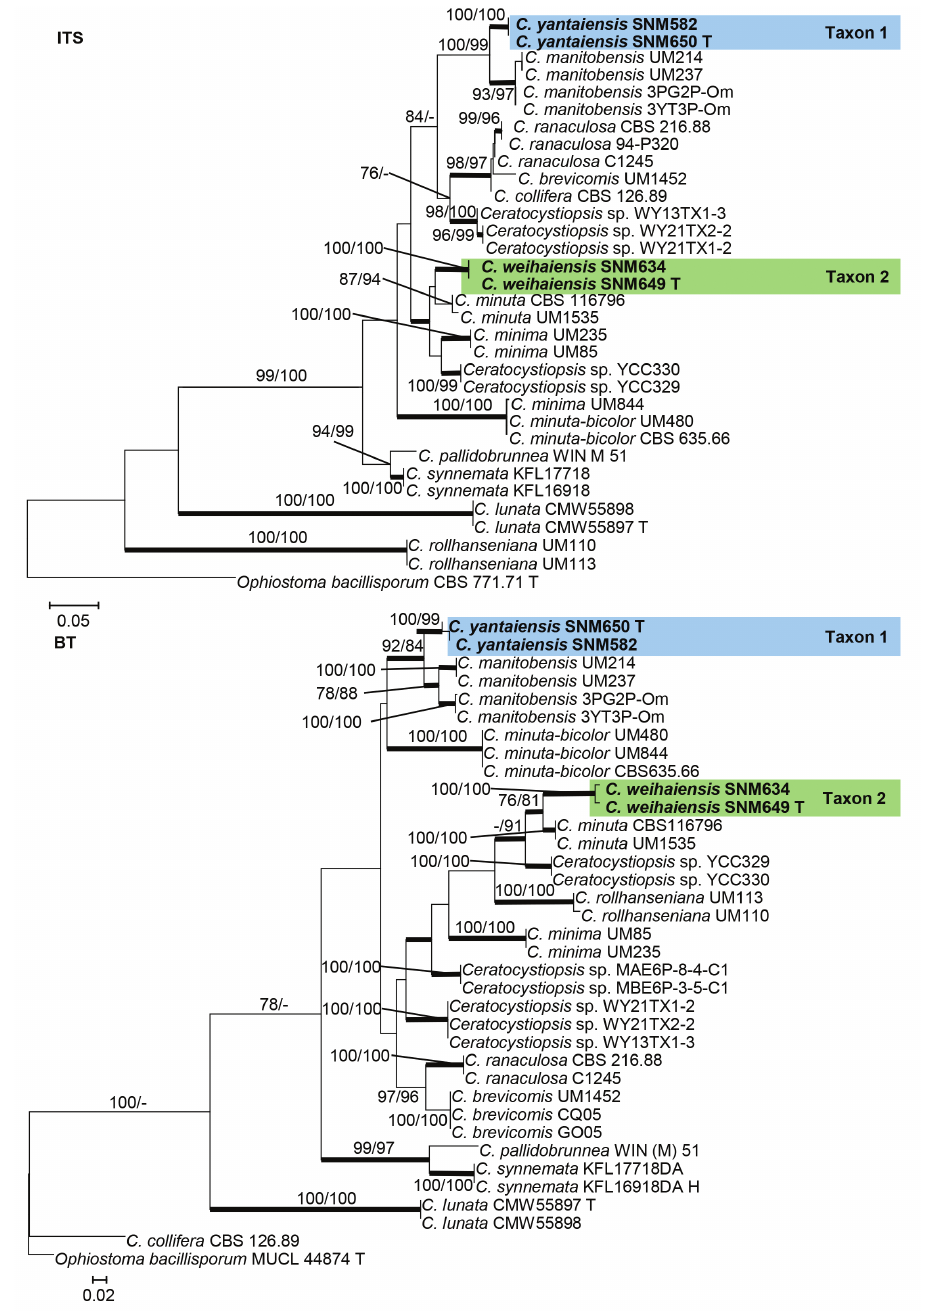
Figure 1. Maximum likelihood phylogeny of Ceratocystiopsis using complete ITS and partial BT gene re- gions. The isolates recovered in this study are highlighted in color and in bold font. ML and MP bootstrap support values ≥ 75 are indicated at the nodes as ML/MP. Bold branches indicate posterior probabilities values ≥ 0.9. T indicates ex-type